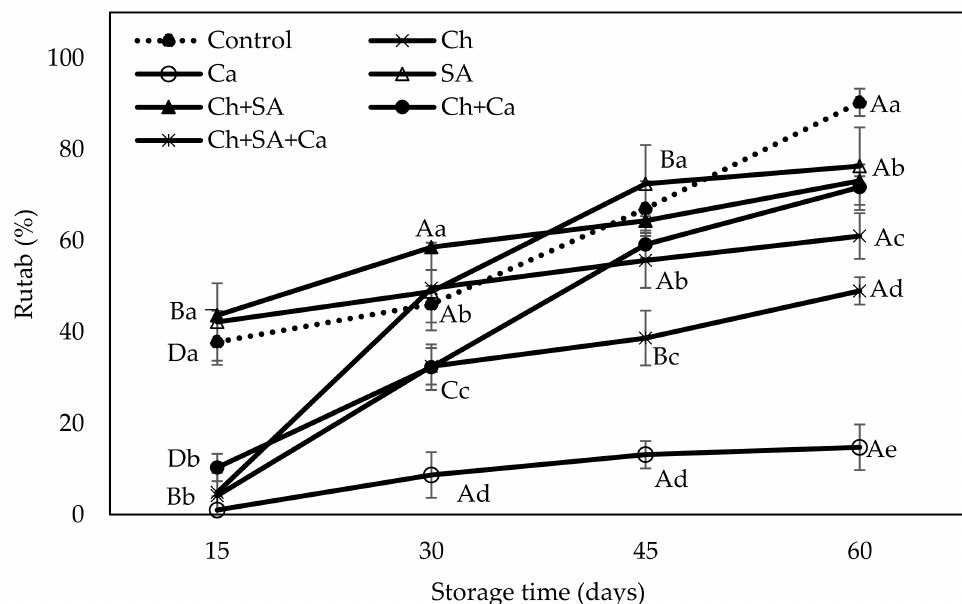
Figure 5. Effects of preharvest application of natural elicitors on “Barhi” fruit’s ripening percentage during cold storage for two months; values are the mean (n = 25) ± SE. The LSD test at p ≤ 0.05 was used to compare the means between treatments. Means with the same letter(s) between treatments within storage time intervals (small letter) and at different time intervals (capital letter) are not significantly different. Ch: chitosan; SA: salicylic acid; Ca: calcium chloride.